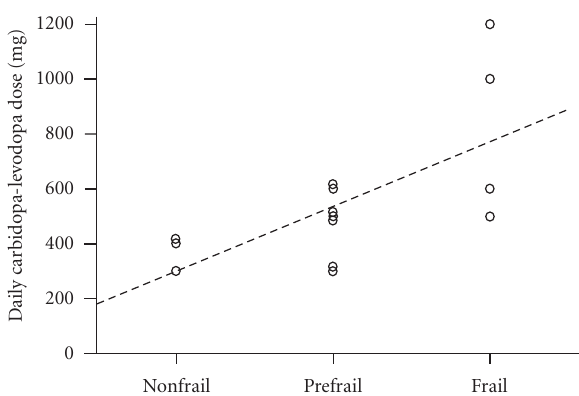
Figure 1: Relationship between frailty severity, measured by Cardiovascular Health Study frailty index, and daily carbidopa- levodopa dose (mg). Increased step count is positively correlated with greater frailty severity ( r = 0 . 61) in females with PD. Females with PD are represented by the open circles and dashed regression line